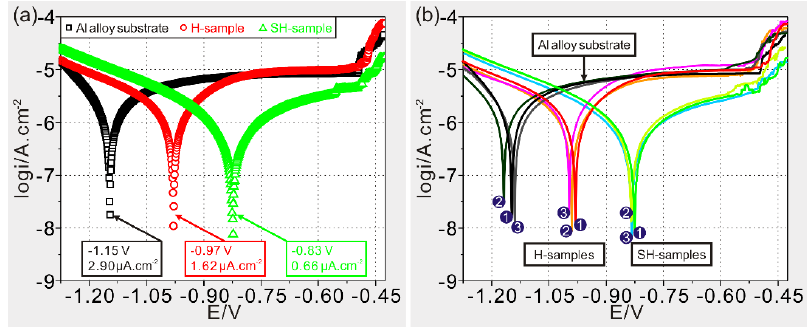
Figure 5. ( a ) Potentiodynamic polarization curves of Al alloy substrate, modified substrate (H-sample) and modified deposited sample (SH-sample); ( b ) consistency analysis of polarization tests for various samples.